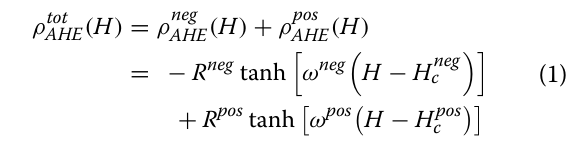
Fig. 4 2AHE model analysis of the hump structure of the CT/BSTS heterostructure. a Separation of ρ AHE ( H ) into the ρ pos AHE and ρ neg AHE at T ρ pos ρ neg AHE ( b ) and AHE ( c ) with varying the temperature in the range of 50–90 K. d , e The coercive fields ( H Hall resistivities ( R pos ( neg ) ) ( e ) of the negative (green) and the positive (yellow) AHE as a function of temperature. f Plot of R pos as a function ρ CT , showing the linear dependence of R pos ∝ ρ CT . g Log‑log plot of R neg vs. ρ BSTS , showing the power law dependence of R neg ∝ ρ BSTS )